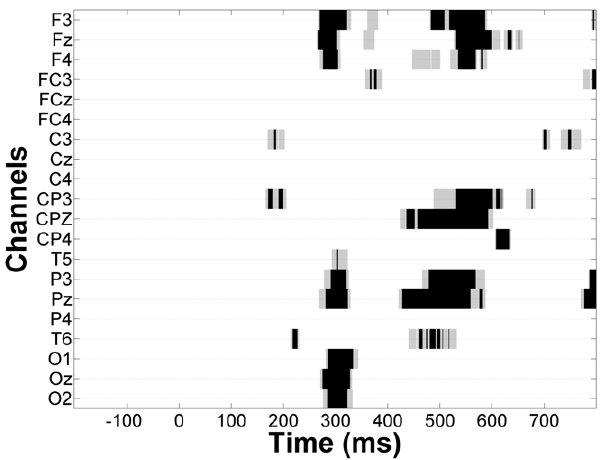
Figure 3. Event-related potential (ERP) components that significantly differ for dual targets. Plot of Q-values from Tukey post-hocs comparisons following significant one-way ANOVAs for ATVI (auditory relevant target and visual irrelevant), AIVT (auditory irrelevant and visual relevant target) and ATVT (audiovisual dual relevant targets) ERPs at each time sample and channel. Shaded regions depict when the ERP for ATVT was significantly different from both, ATVI and AIVT ERPs for 12 consecutive samples. White regions p . .05, grey regions p , .05 and black regions p , .01.